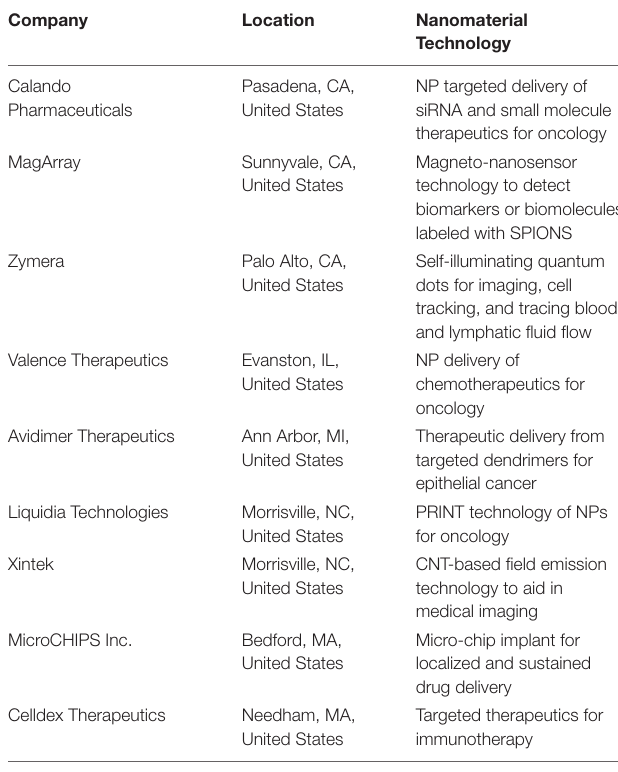
TABLE 3 | Sampling of start-up Companies from the NCI: Company Name and Nanomaterial Technology.